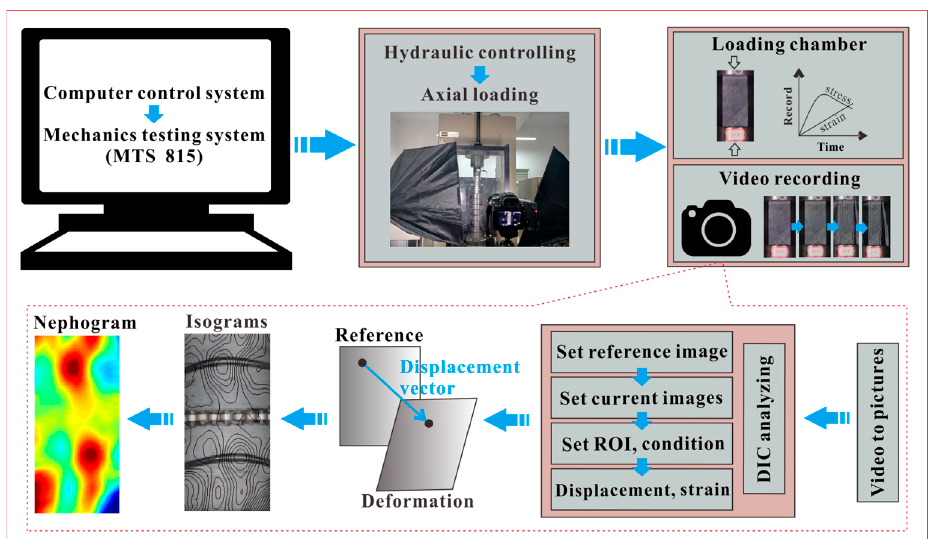
Figure 7. Digital image correlation (DIC) test and schematic diagram of test data processing. Table 2. Controlling parameters of Mechanics Testing System.